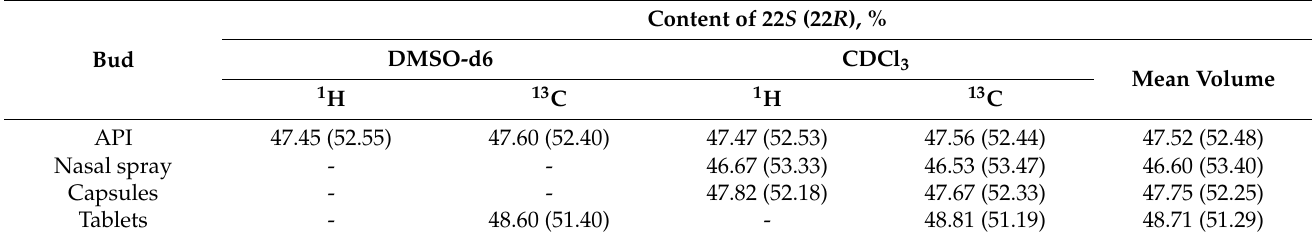
Figure 10. 13 C spectra fragments of the Bud tablets solutions in DMSO-d6 ( a ) and CDCl 3 ( b ) with characteristic signals of 22 R and 22 S epimers. Table 2. The quantitative measurements results of the content of 22 S and 22 R epimers in the Bud-API and Bud drugs.